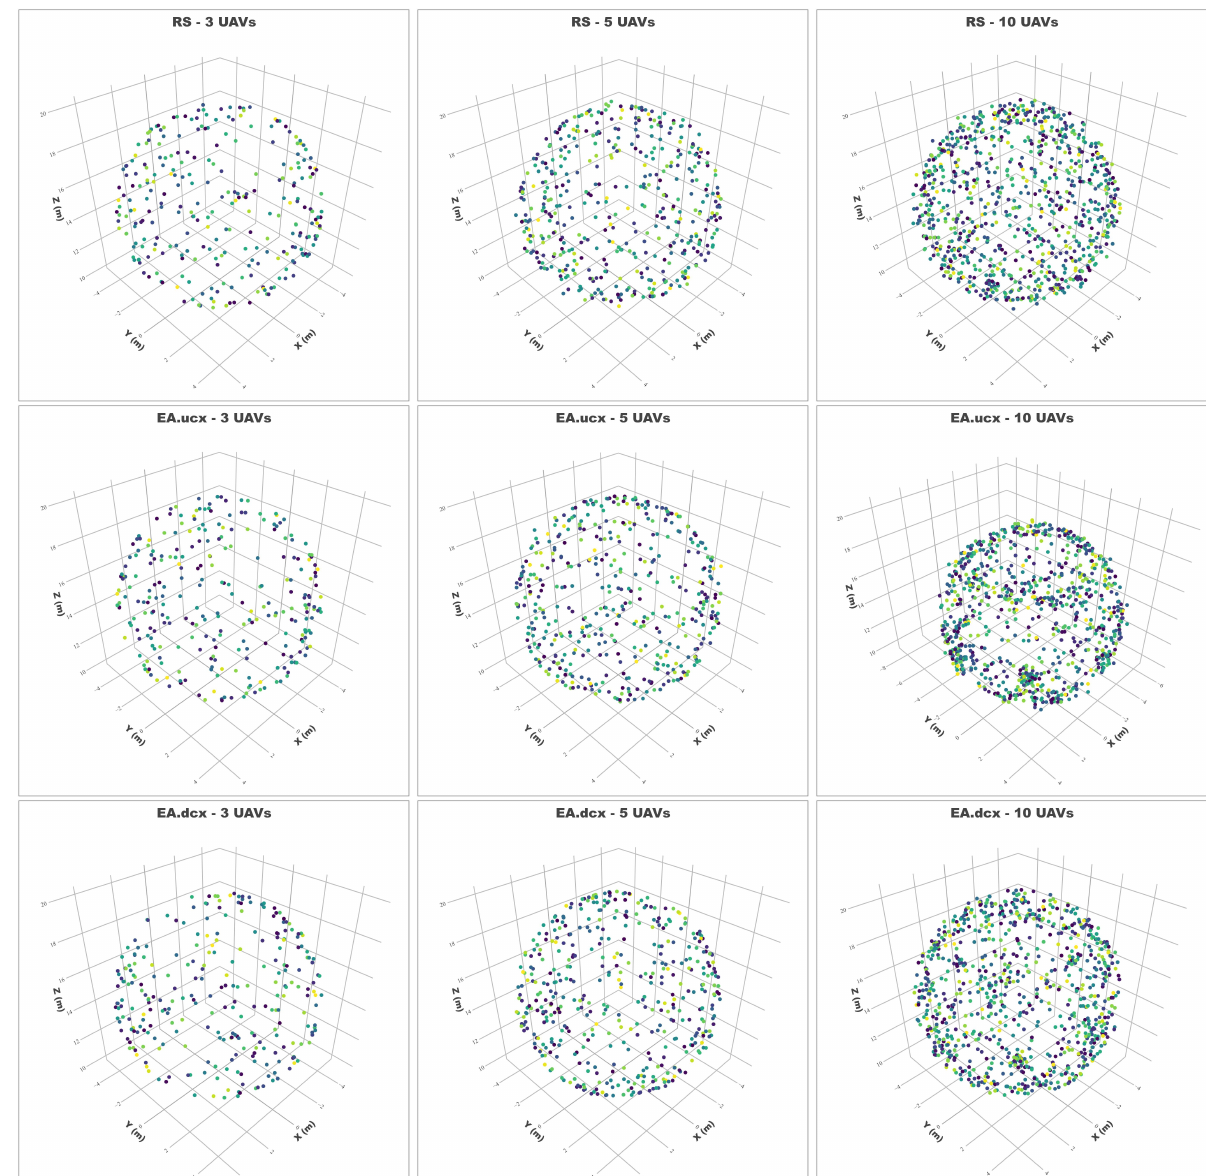
Figure 11. UAVs’ final position for the 90 testing scenarios per case study and